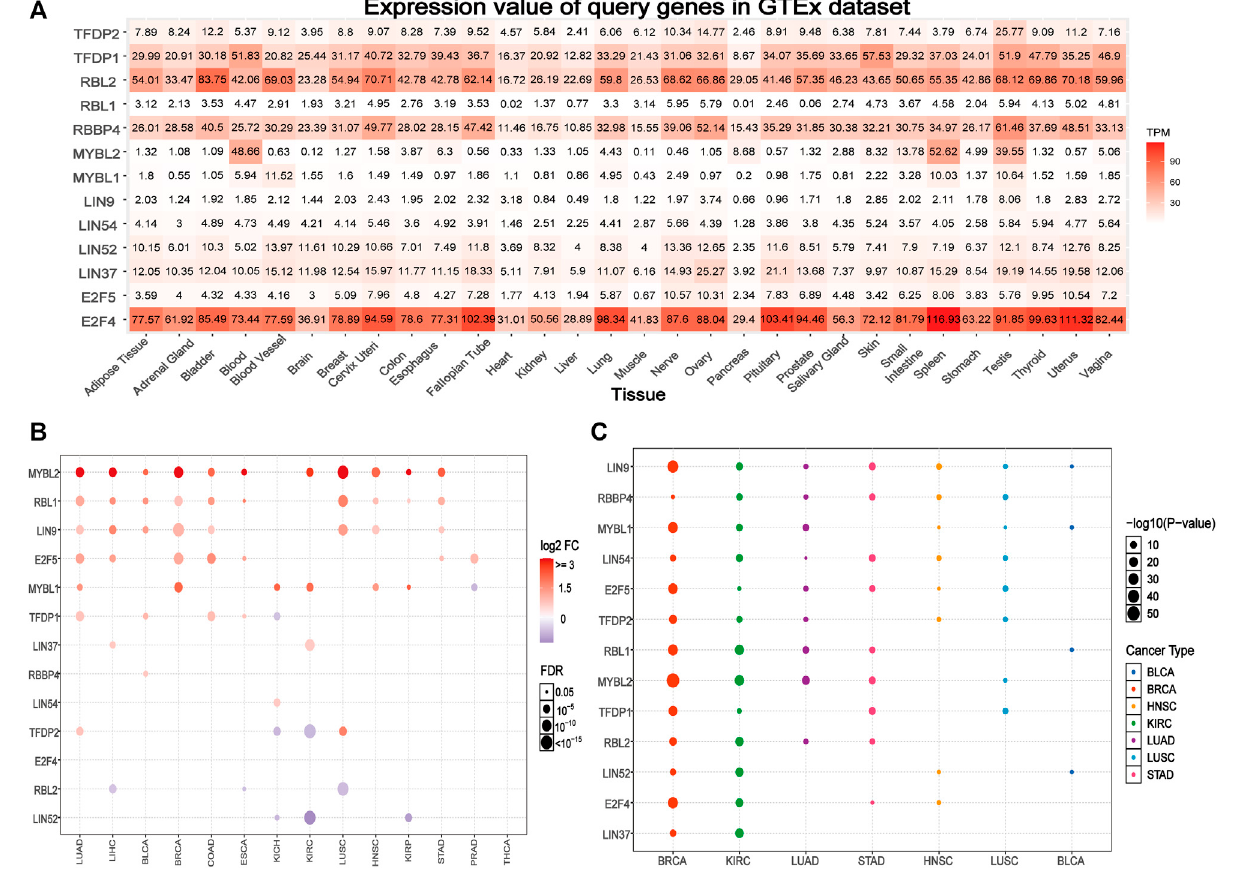
Frontiers in Genetics |